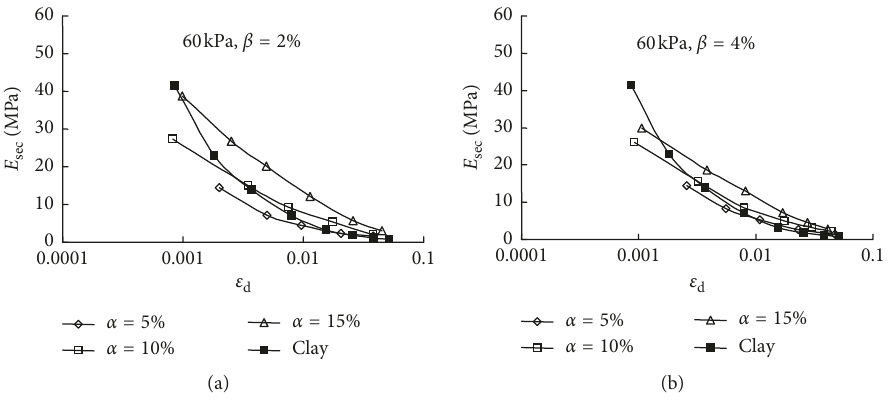
Figure 9: The curve of E